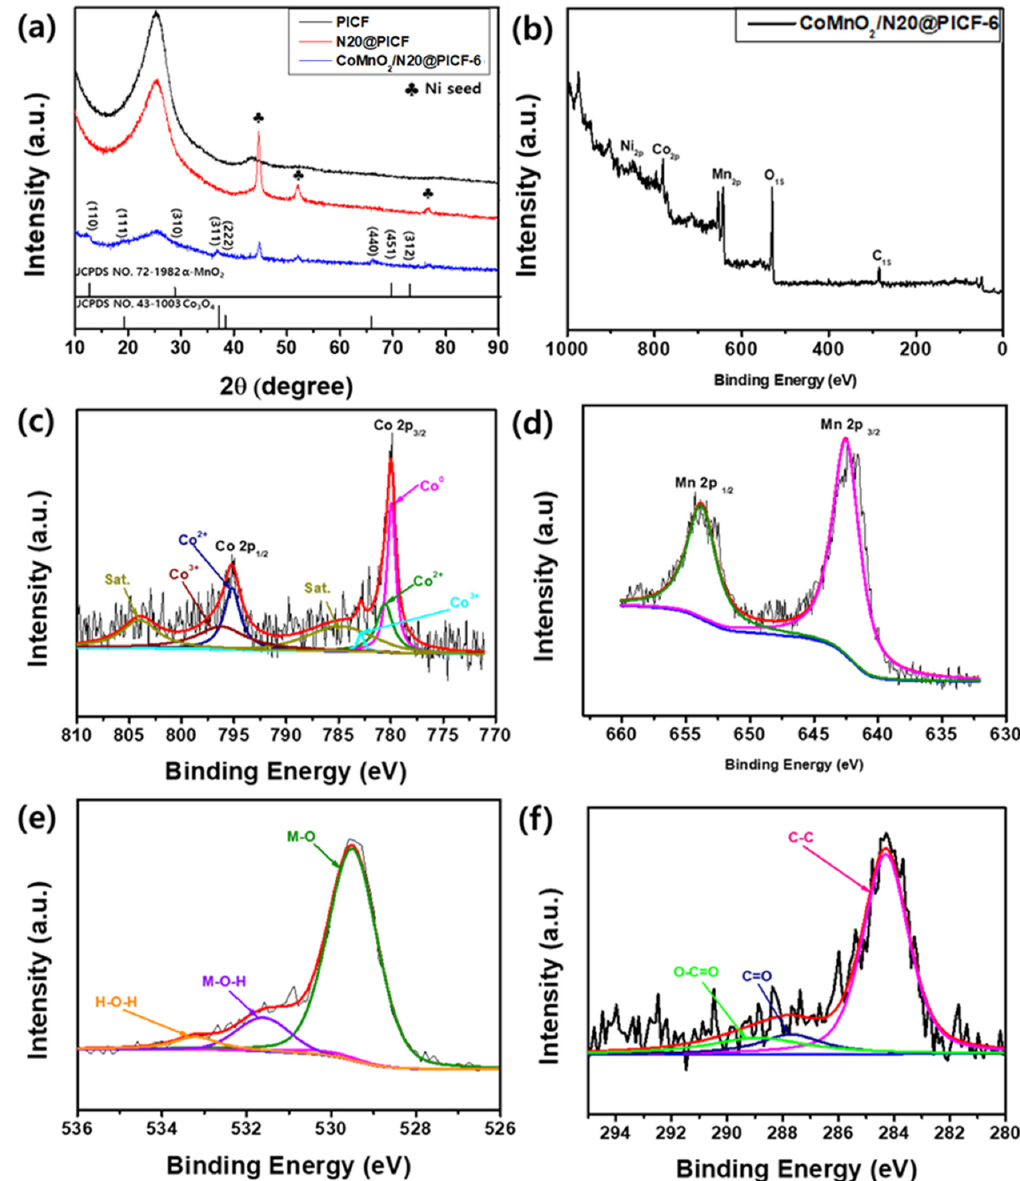
Figure 4. XRD patterns ( a ) of pure PICF, N20@PICF and CoMnO 2 / N20@PICF-6. The XPS survey spectrum ( b ) of CoMnO 2 /N20@PICF-6 and XPS spectra of Co 2p ( c ), Mn 2p ( d ), O 1s ( e ), C 1s ( f ) for CoMnO 2 /N20@PICF-6 in high resolution.